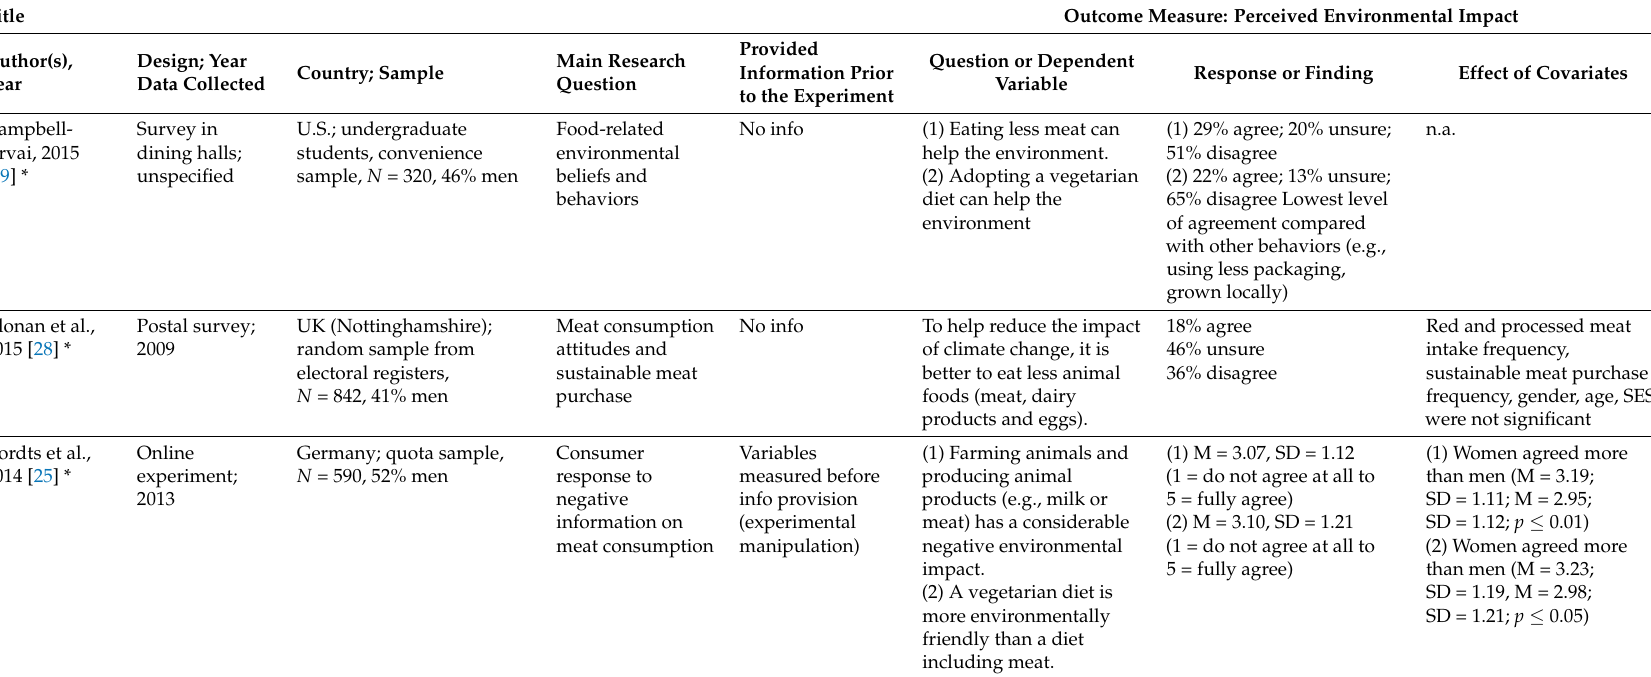
Table A1. People’s awareness of the environmental impact of meat production and